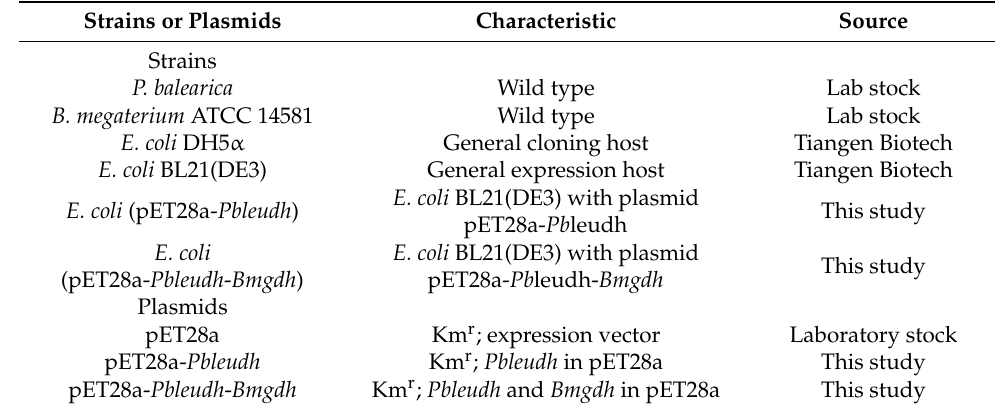
Table 3. Bacterial strains and plasmids used in this study.